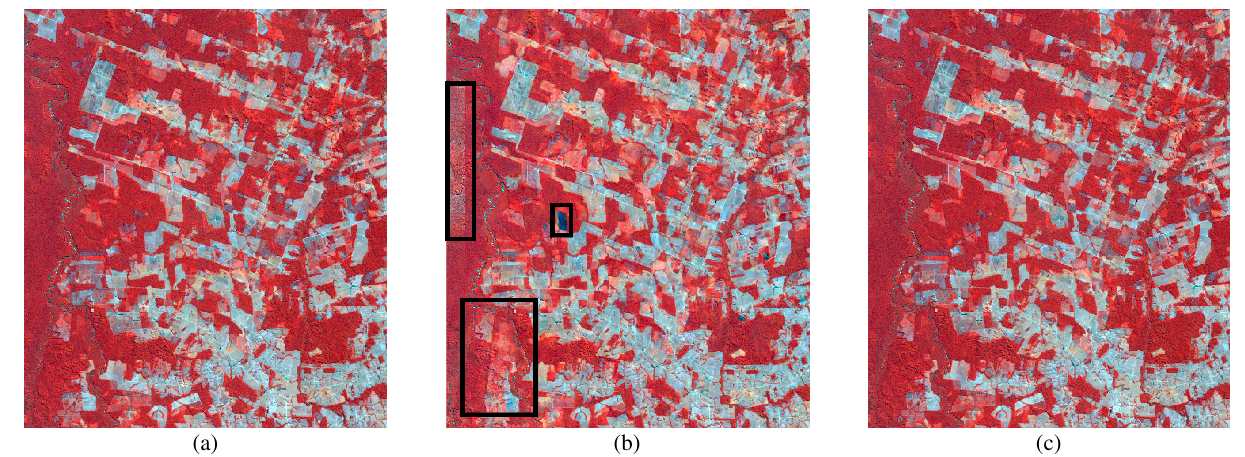
Figure 5. Resulting images from the adaptation process.(a) Original image of 2016 from source domain. (b) Adapted version of the source domain’s image to the target one where artifacts where generated by the model (Compare the regions inside the black boxes).(c) Adapted version of the source domain image to the target one applying the constrain proposed in the Equation 9. in the deforestation monitoring, we also studied the influence of DA in this context. As in this system the photo-interpreter just needs to analyze areas which the classifier indicates as likely